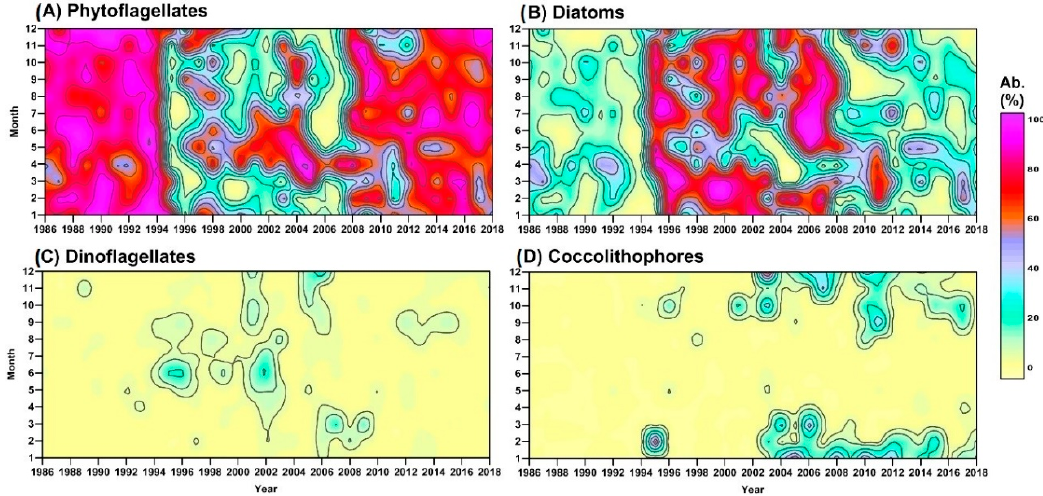
Figure 4. Contribution (%) to total cell abundance of the four most important phytoplankton groups (( A ), Phytoflagellates; ( B ), Diatoms; ( C ), Dinoflagellates; ( D ), Coccolithophores) in